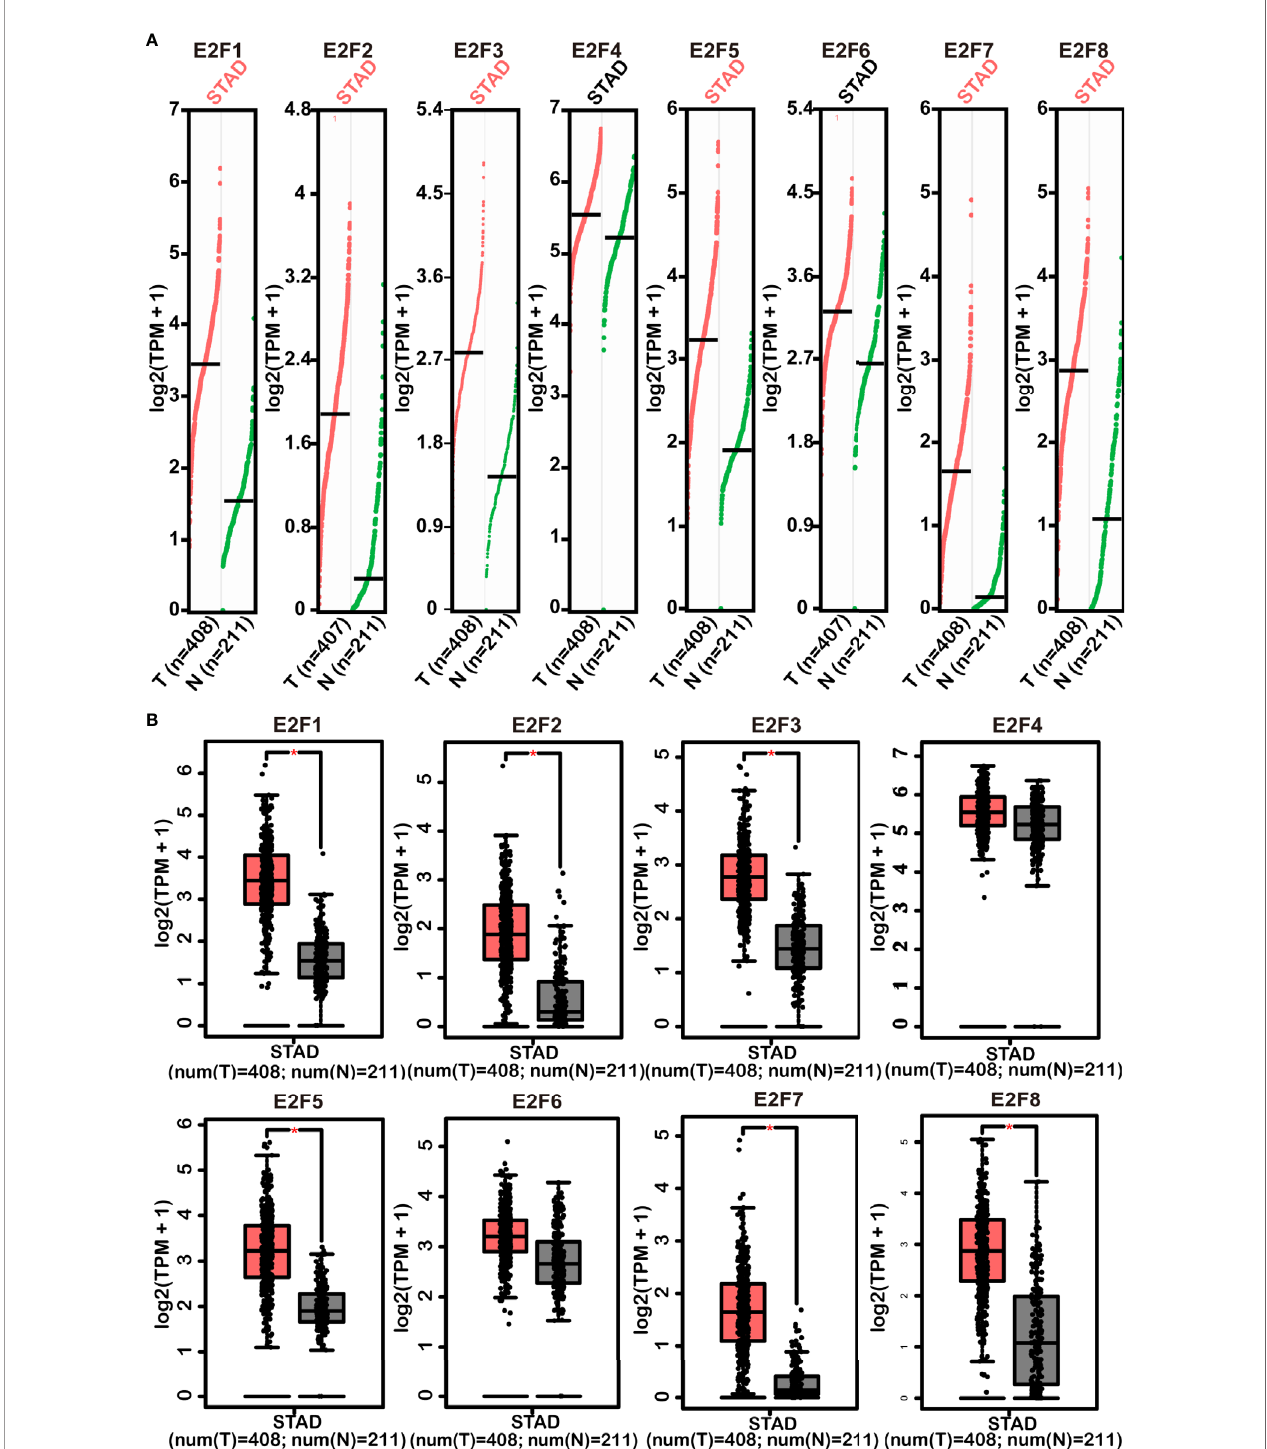
FIGURE 2 | Comparisons of mRNA levels of E2Fs in STAD tissues with those in normal stomach tissues (GEPIA2). Scatter diagram (A) and box plot (B) represented differences of the mRNA level of E2Fs between STAD tissues and normal controls. Multiple testing correction was conducted using the false discovery rate (FDR) method. The parameters were set as follows: p = 0.01, |Log2FC| = 1, matched normal data = match TCGA normal and GTEx data. Red versus grey in (B) represents tumor tissues versus normal tissues. The pink STAD in (A) and * in (B) indicate that the differences are statistically signi fi cant. STAD, stomach adenocarcinoma; TPM, transcripts per million; T, tumor samples; N, normal